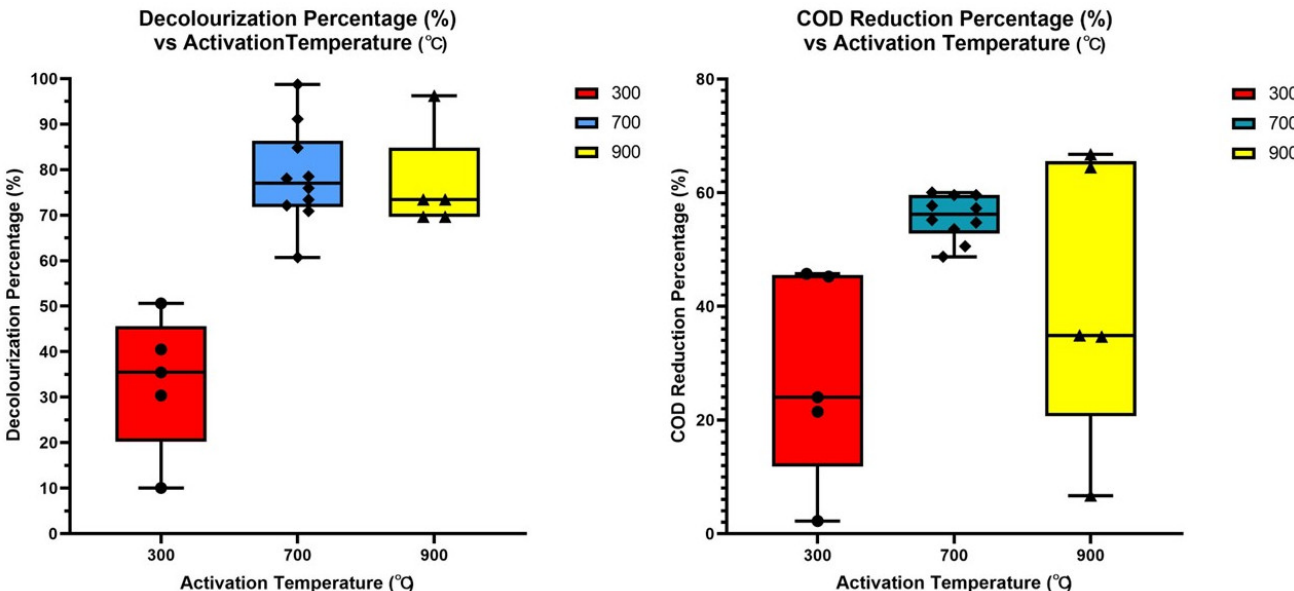
Figure 6. The decolourisation percentages ( left ) and COD reduction percentages ( right ) of RTDW based on activation temperature.